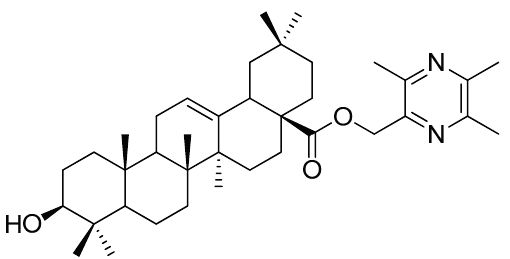
Figure 1. The structure of the anticancer lead compound